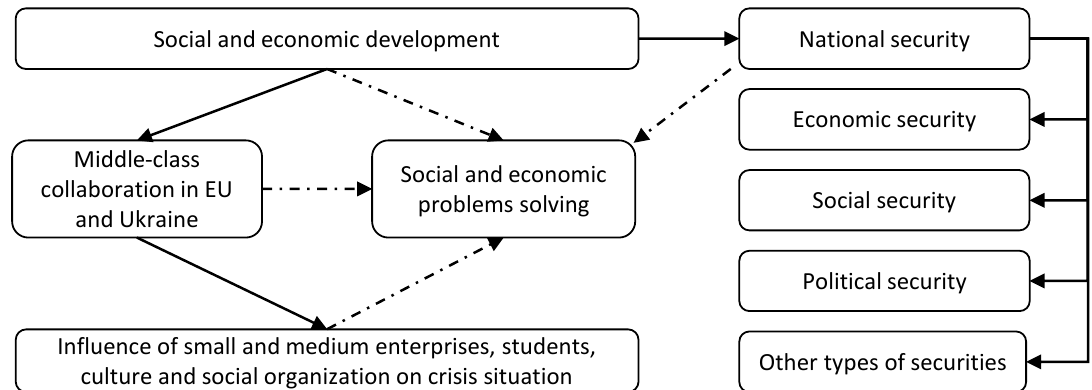
Figure 2. Mechanism of social and economic problems of war conflict in Ukraine solving (European